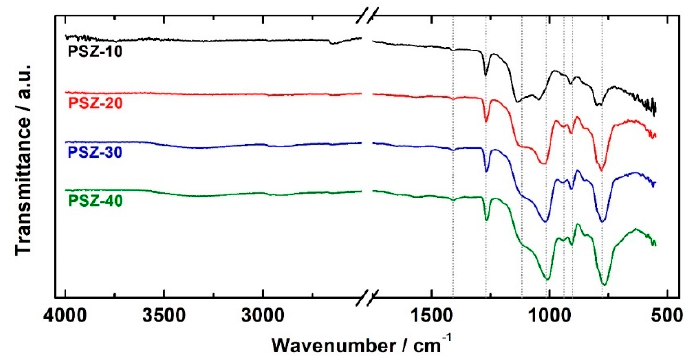
Figure 4. FT-IR spectra of the investigated coatings.